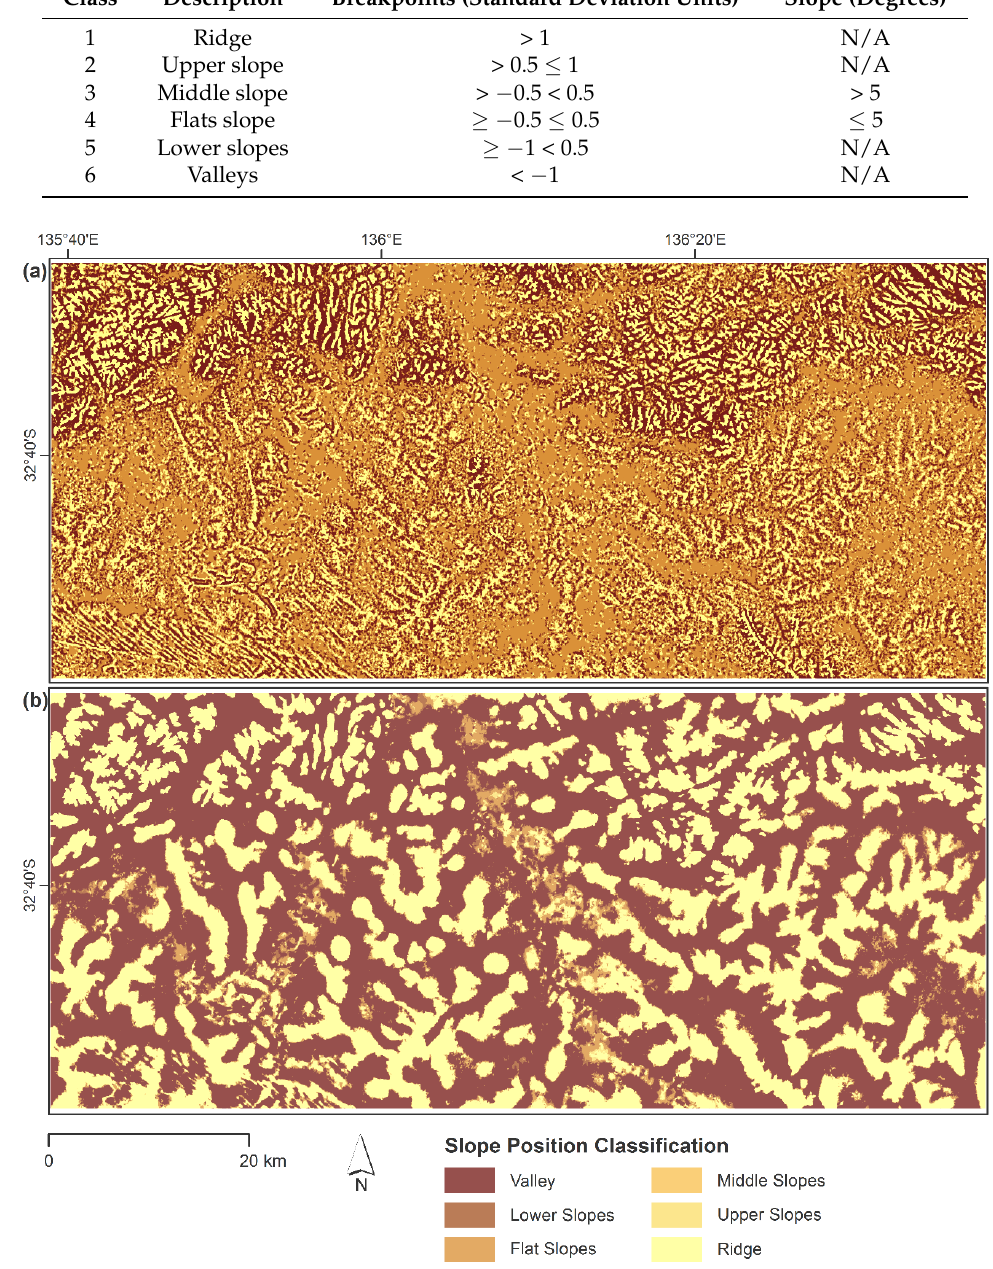
Figure 6. Slope Position Classification at ( a ) fine scale (300 m); and ( b ) coarse scale (2000 m) derived using Dilts [52] ArcGIS 10.3 Toolbox. SPC is based on the local elevation and slope of each point.